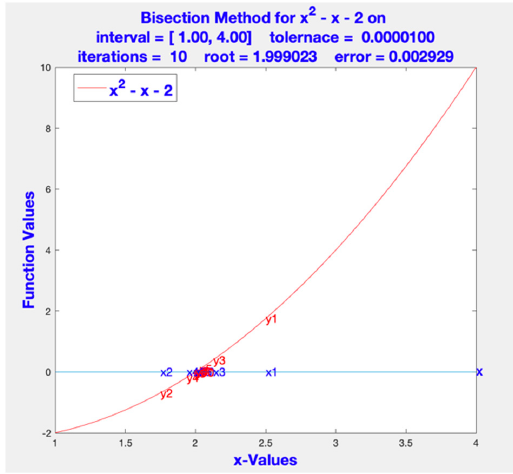
Figure 6. Plot of bisection algorithm execution.